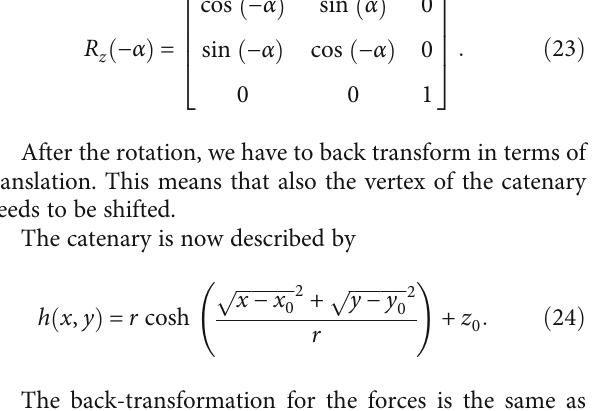
Figure 3: Three-dimensional catenary. The suspension points are a = ð 2, 2, 4 Þ and b = ð 0, 0, 4 Þ which leads to x = 0 . The catenary function can always be reduced to a plane problem with a rotation angle α